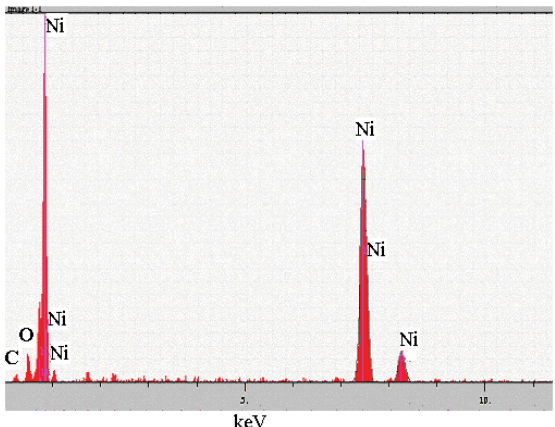
Figure 5. EDS spectrum of sample S